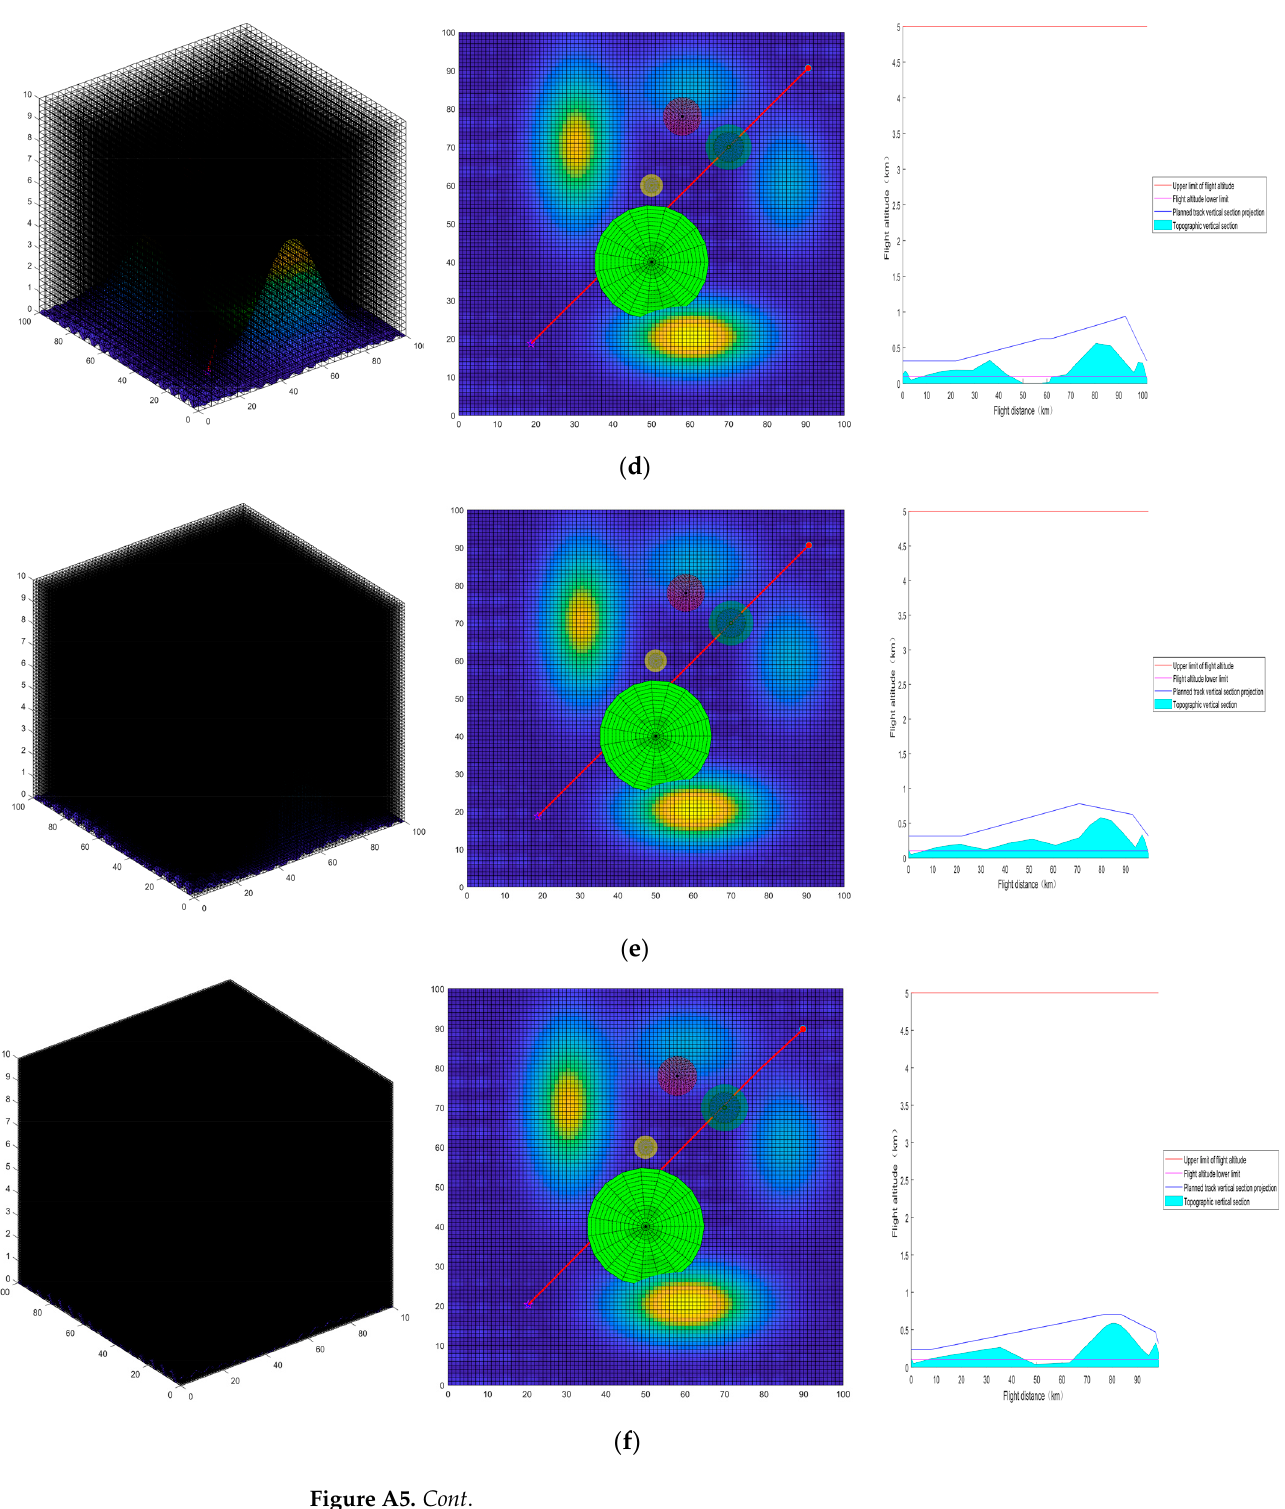
( g ) Figure A5. Lazy Theta* route planning at different grid levels. ( a )